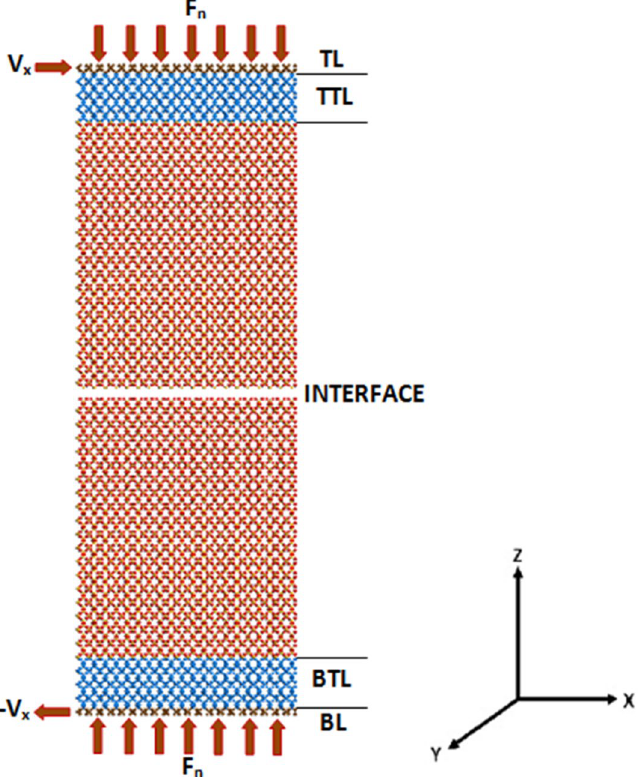
Figure 9. Schematic of the system consisting of two slabs with the top layer (TL), top thermostatted layer (TTL), the interface between the two slabs, the bottom thermostatted layer (BTL), and the bottom layer (BL). F n is the normal force applied, while V x is the sliding velocity that pulls the top layer in the y direction relative to the bottom